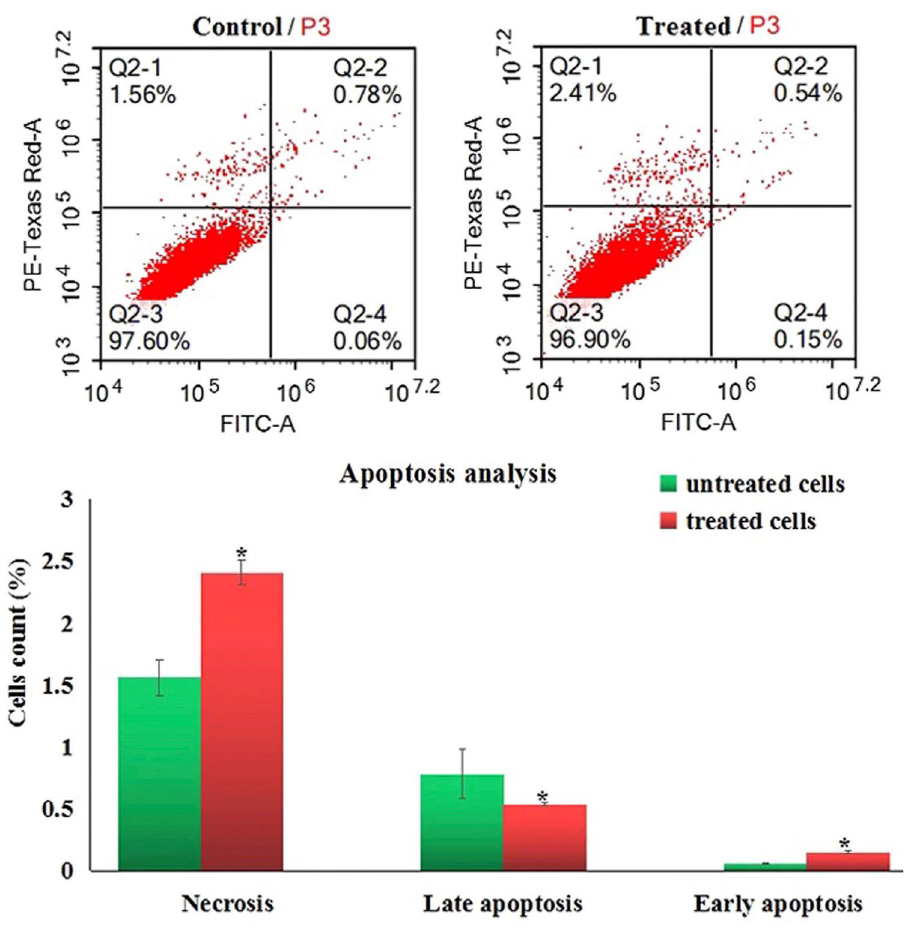
Figure 10. Induction of apoptosis in the control and treated Hep-G2 cells with IC 50 /72 h (6.21 µg/ml) of Erbium Oxide nanoparticles. Q2-1 denotes necrosis phase; Q2-2 denotes late apoptosis phase, Q2-3 denotes normal viable cells and Q2-4 denotes early apoptosis